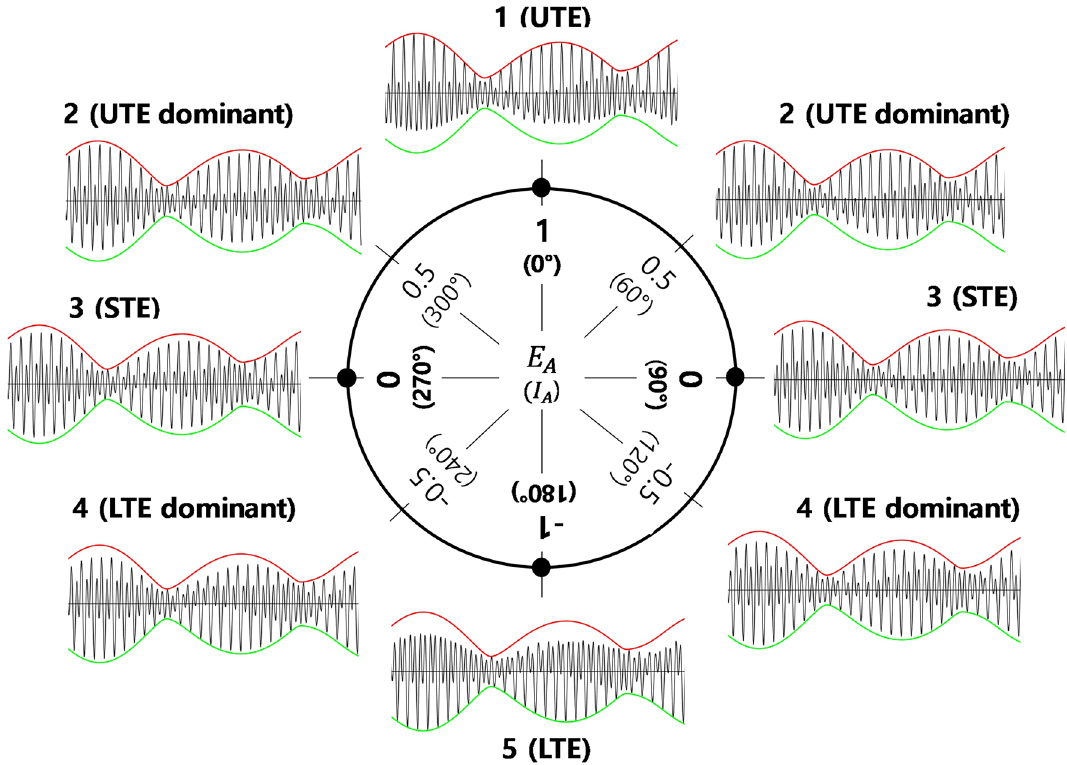
Figure 3. Monthly tidal envelope patterns calculated for a mixed, mainly semidiurnal tidal regime from the tidal amplitude and phase lag values of 5 major tidal constants (Table 1), and classified according to phase lag differences [ E A = cos ( I E ) , I E = ( g K 1 + g O 1 ) − g M ]. UTE and LTE denote upper tidal envelope and lower tidal 2 envelope, respectively. STE denotes a near-symmetric tidal envelope. Red and green lines denote the potential maximum upper and lower envelopes (PUE and PLE), calculated from Eqs. (5a),